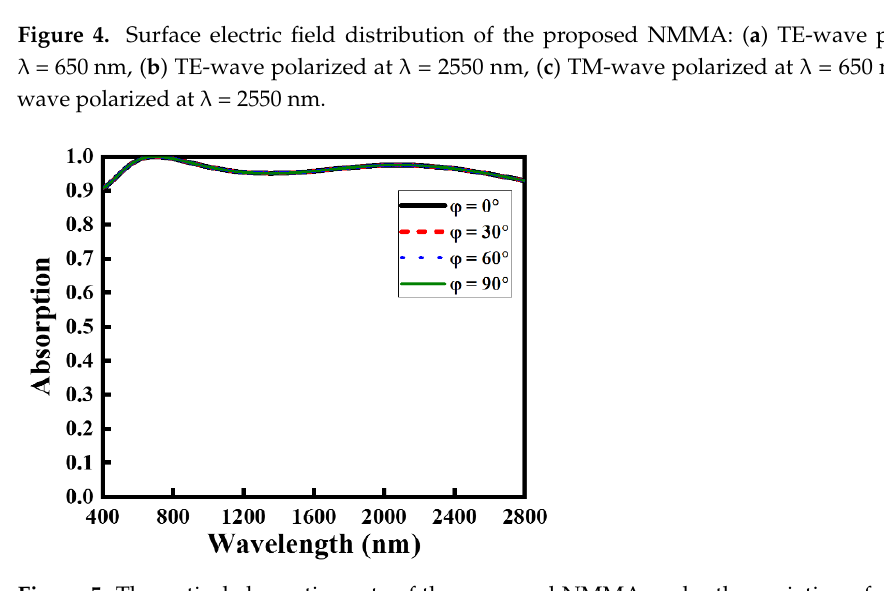
Figure 4. Surface electric field distribution of the proposed NMMA: ( a ) TE- wave polarized at λ = 650 nm, ( b ) TE- wave polarized at λ = 255 0 nm, ( c ) TM- wave polarized at λ = 6 50 nm, ( d ) TM-wave polarized at λ = 255 0 nm.